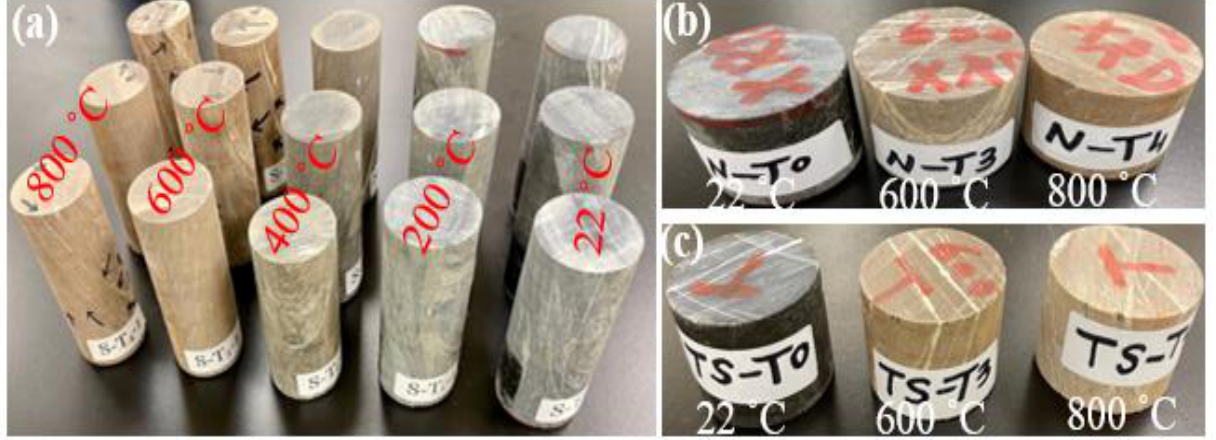
Figure 2. Specimens before and after heating: ( a ) specimens for experimental work; ( b ) specimens for chemical/mineralogical/morphological analyses; ( c ) specimens for petrographic (thin section) analysis.